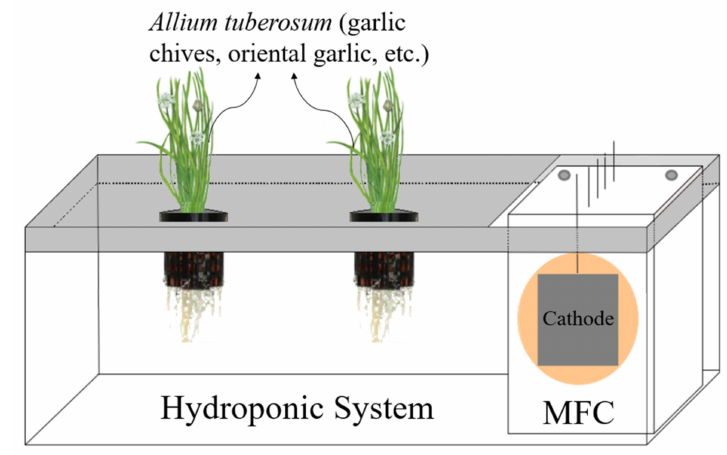
Figure 3. The MFC-Hyp